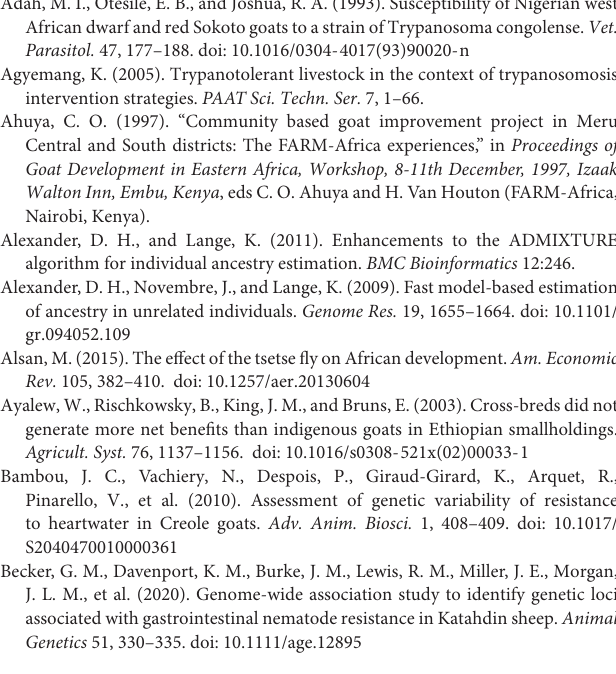
Supplementary Text 1 | East African admixture analysis, including exotic breeds and crossbred